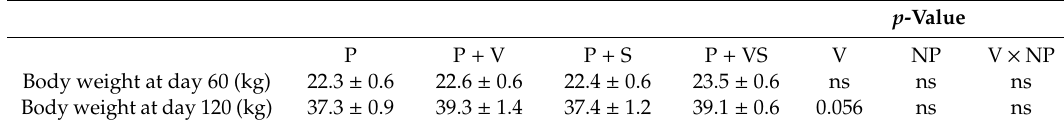
Table 3. E ff ects of maternal nutritional plane and vitamin C and E supplementation on body weight at mid-lactation (60 days) and at weaning (120 days) of lambs born from ewes kept in extensive grazing under Patagonian